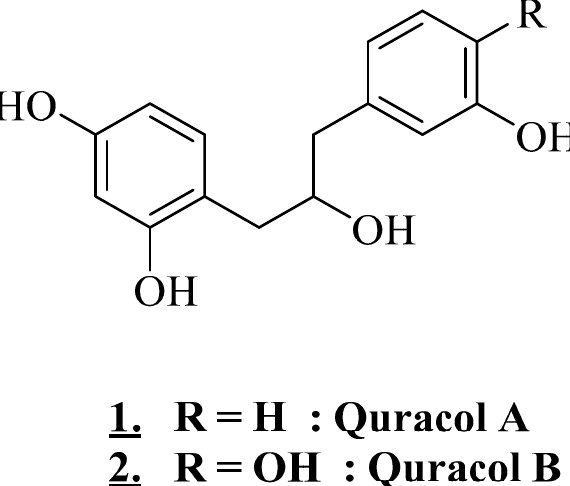
Figure 5. Structures of the main alcohols in V. tortilis ( 1 ), ( 2 ).